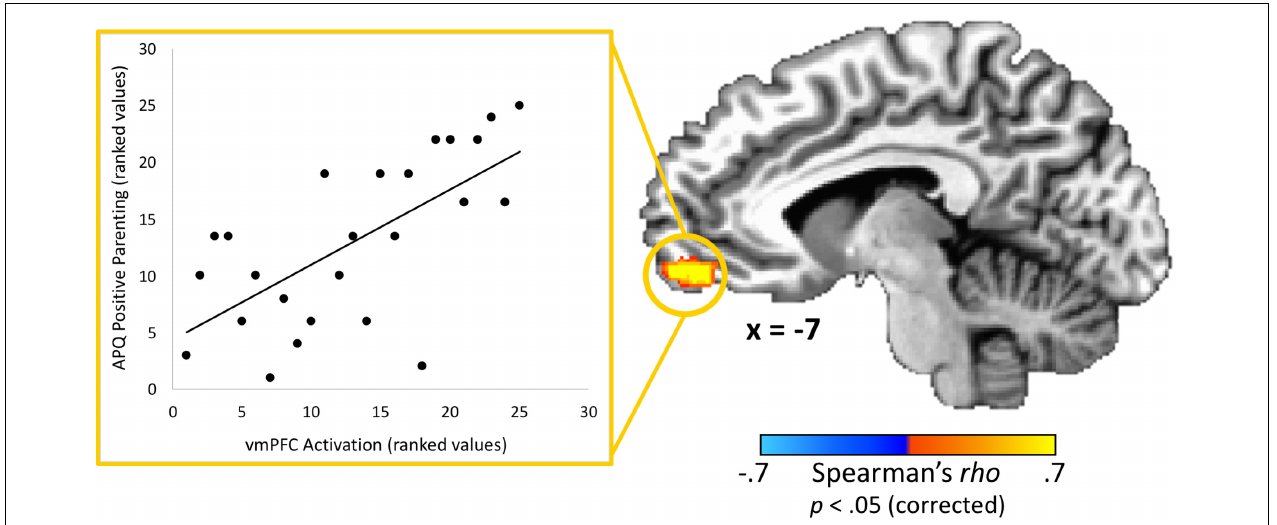
FIGURE 3 | Relationship between adolescents’ ratings of their parents’ positive parenting and parents’ brain response to their adolescent child’s costly error. A region-of-interest analysis revealed that the vmPFC exhibited a significant positive correlation between positive parenting practices (as reported by the adolescent) and parents’ brain response when their child made a costly error. Higher vmPFC activation was associated with positive parenting practices. Scatterplot data represent mean activation in the identified region (ranked within-group) and are provided for visualization purposes only. Coordinates are in Talairach space.